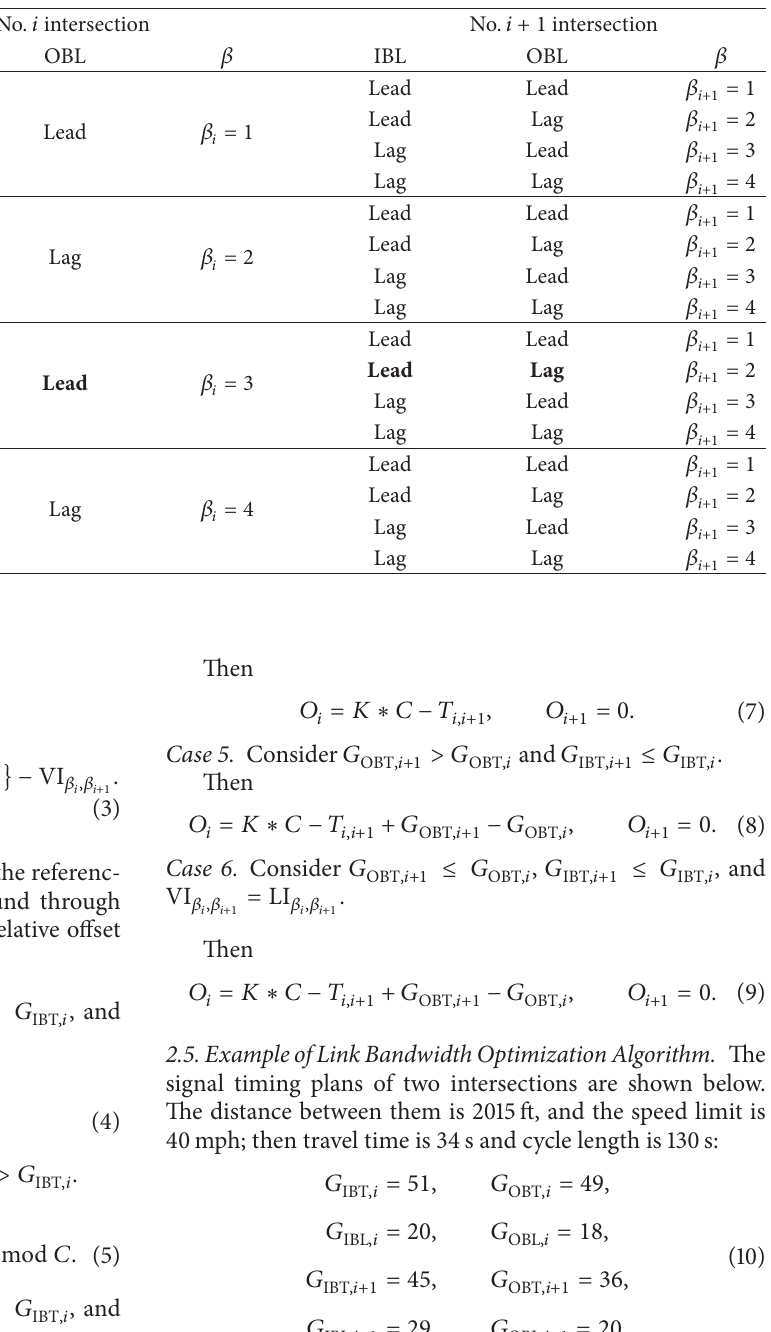
Table 2: Phase sequence combinations of two consecutive